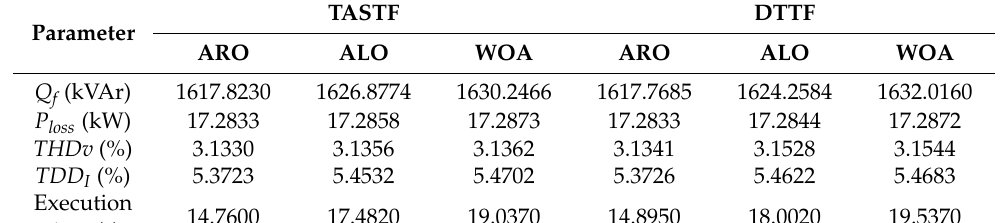
Table 3. Results obtained by the optimization algorithms.